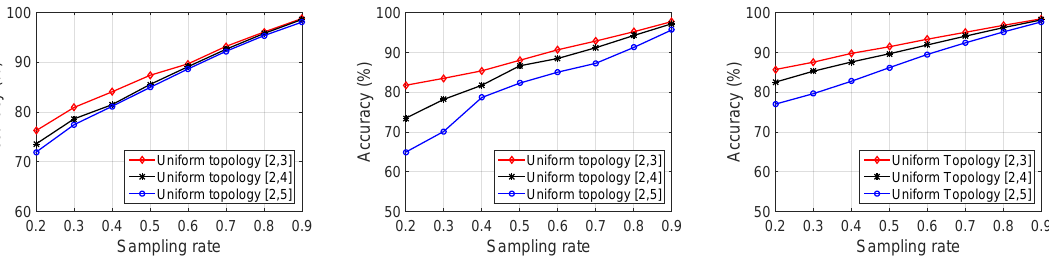
Figure 16. Evaluation of performance in the uniform